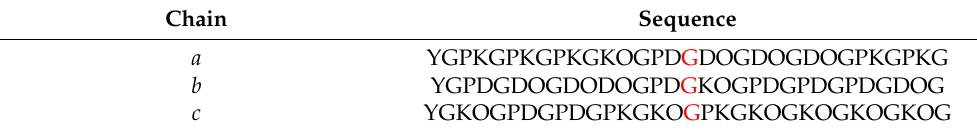
Table 1. Sequence of heterotrimer abc. Chain Sequence a YGPKGPKGPKGKOGPDGDOGDOGDOGPKGPKG b c